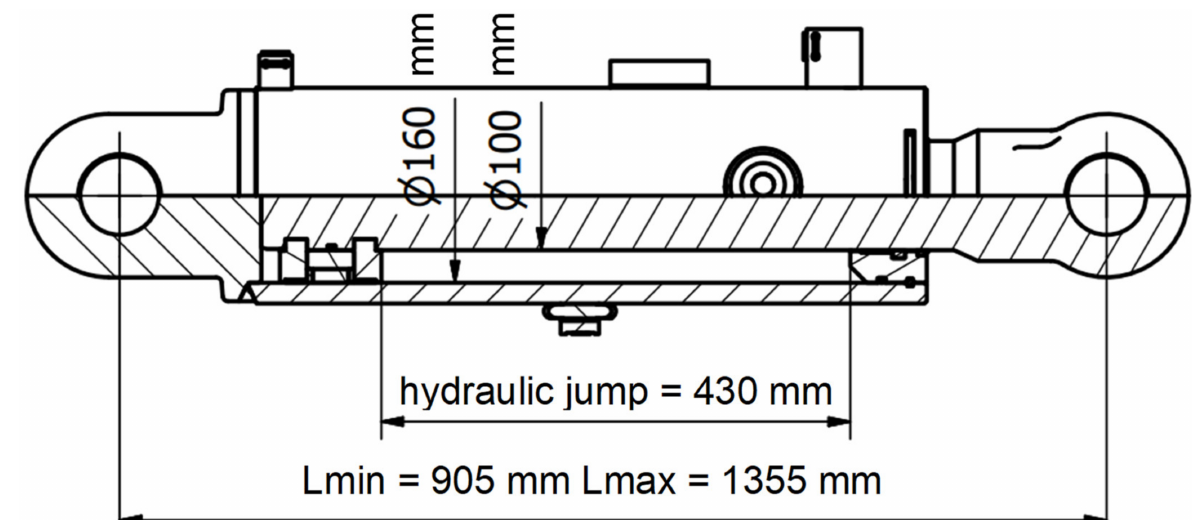
Figure 2. Cross-section view of the actuator of the powered roof support.